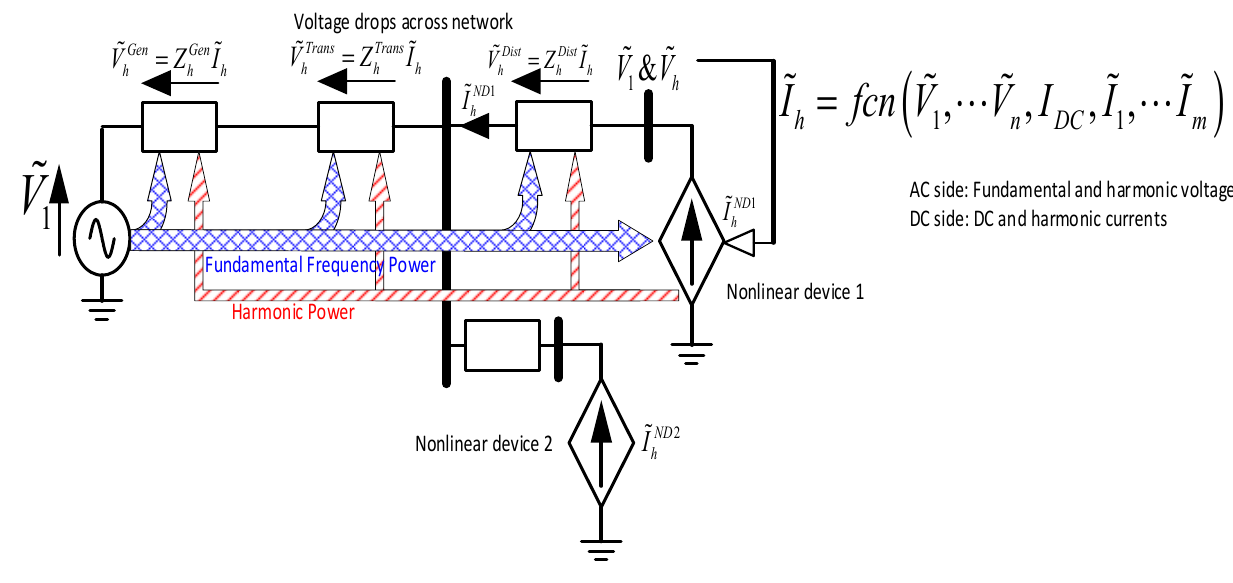
Figure 1. Nonlinear device interactions through the system impedance.